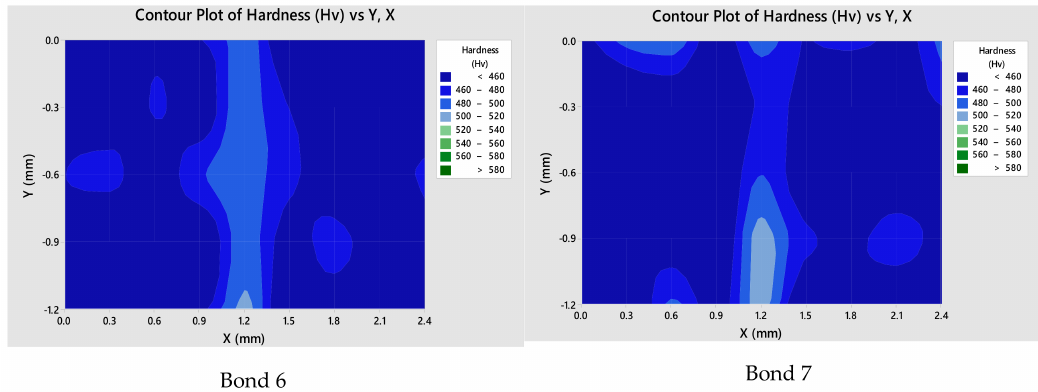
Figure 9. Contour maps showing variation in hardness for